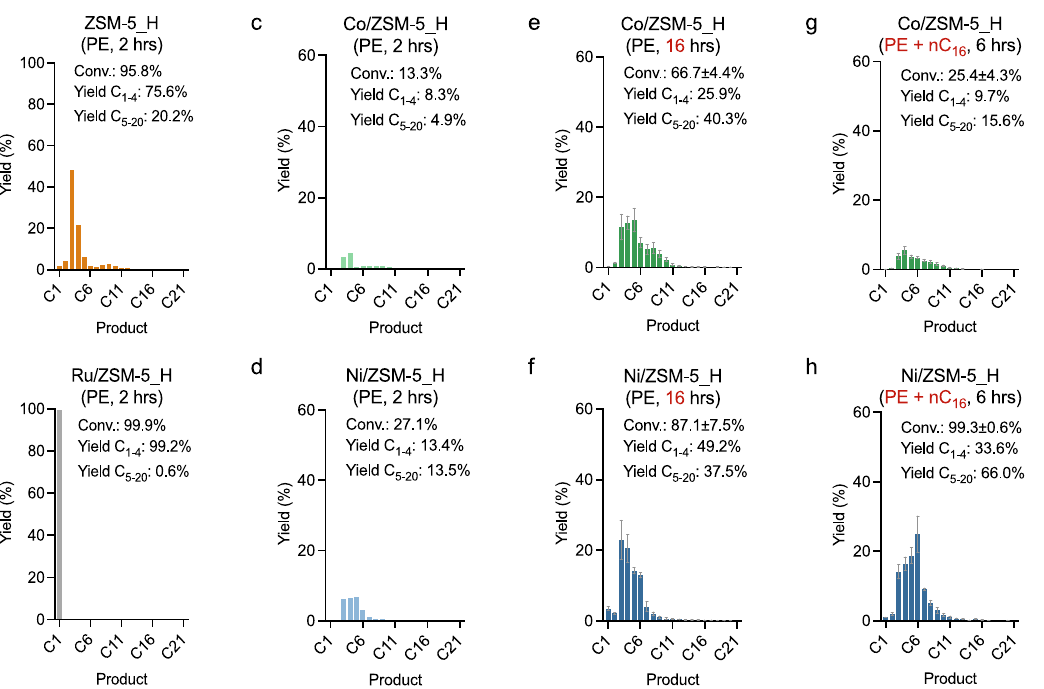
carbon) depolymerization under the solvent-assisted condition: nC 16 (1.4g,